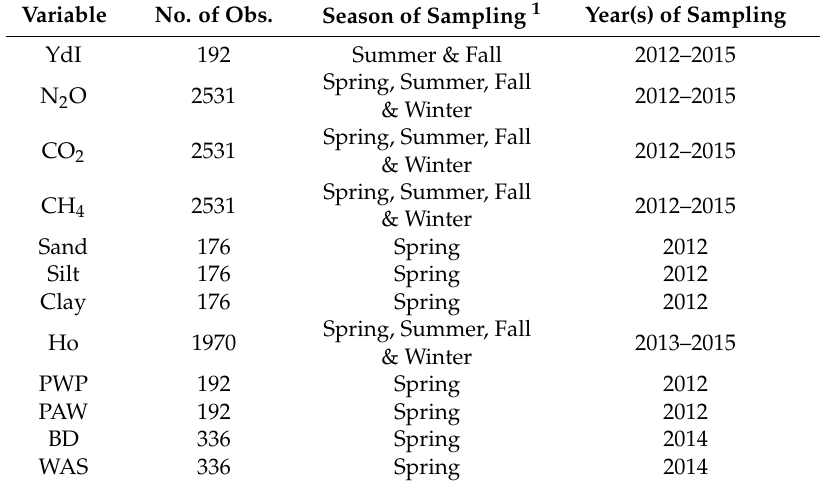
Table A3. Number of observations, season of sampling, and year of sampling originally included for each variable throughout the study (2012–2015) from Monmouth,